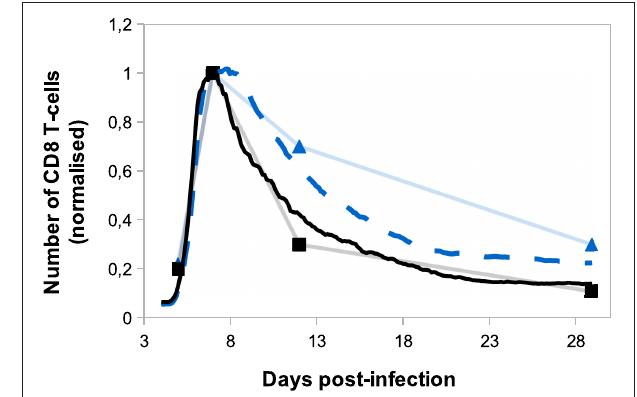
FIGURE 8 | Number of CD8 T-cells, normalised by CD8 T-cell population size D7 p.i., during in silico primary (black full line) and secondary (blue dashed line) responses (mean over 10 simulations) compared with in vivo primary (black squares) and secondary (blue triangles) responses against Listeria monocytogenes from Badovinac et al. (63).